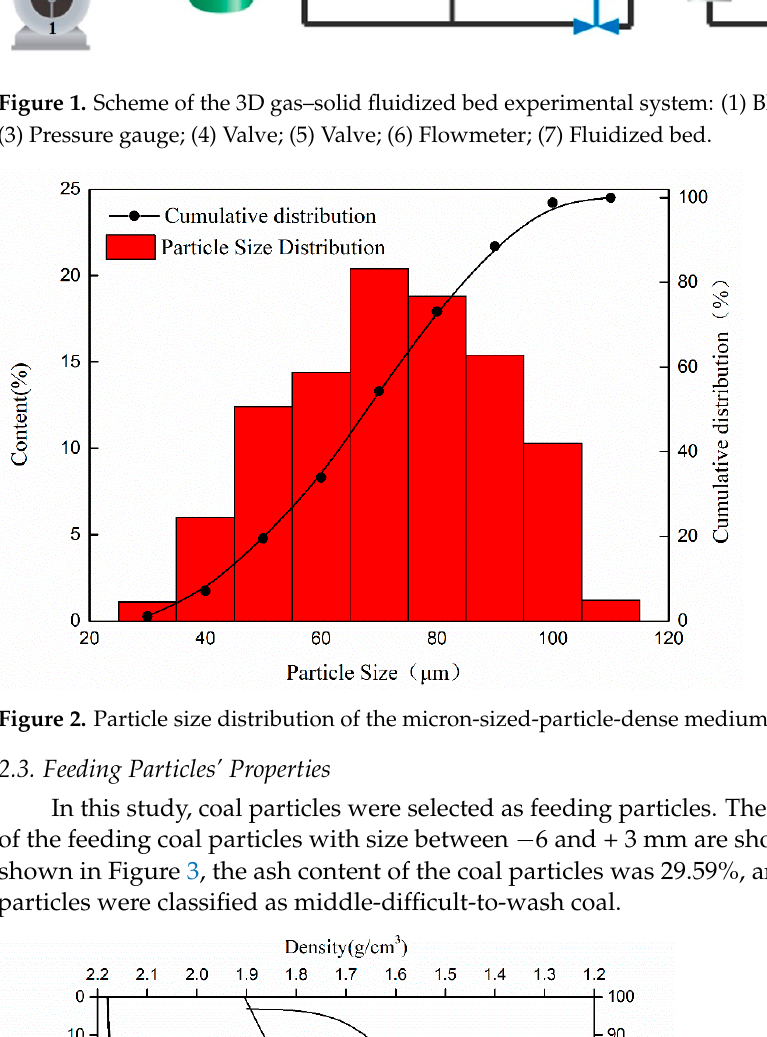
Figure 2. Particle size distribution of the micron-sized-particle-dense medium.